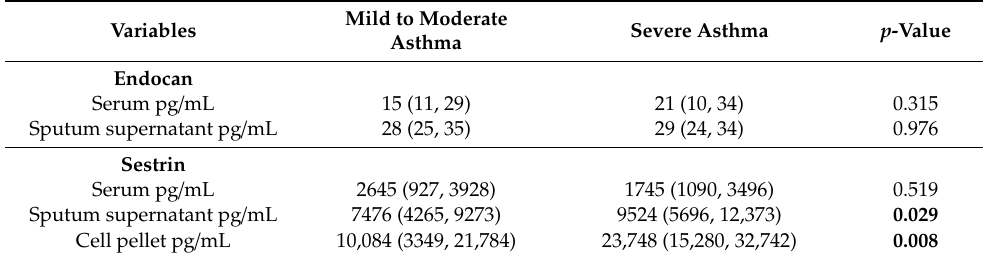
Table 2. Inflammatory variables in di ff erent biological samples.